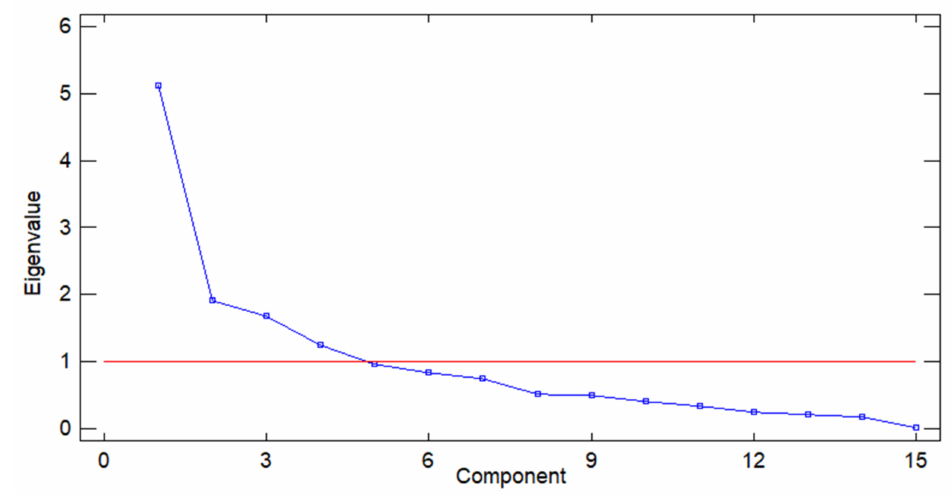
Figure 7. Eigenvalues of the